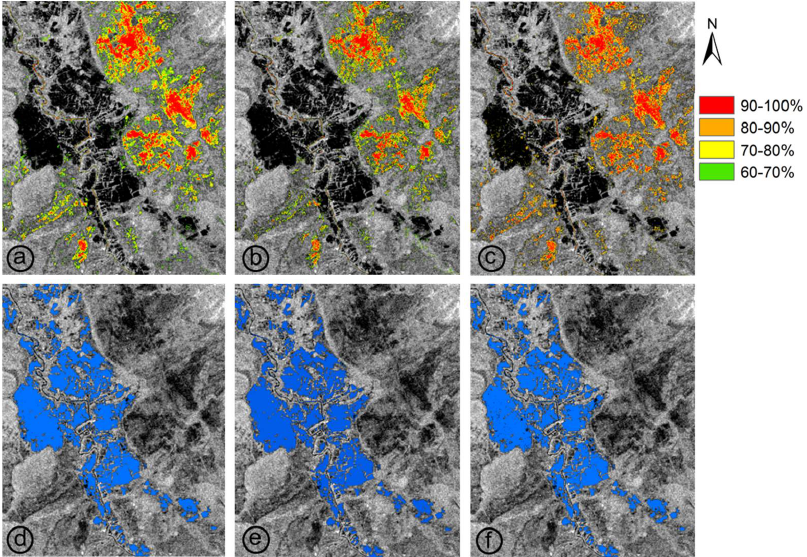
Figure 9. Relative frequency classes 60–100% ( τ < −15 dB) for the time-series ( a ) 2014–2017 (1 June